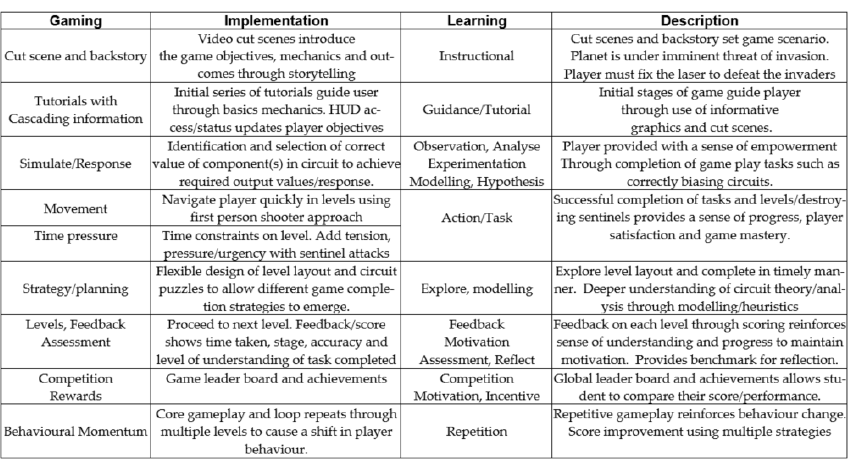
Table 3. Circuit Warz extended